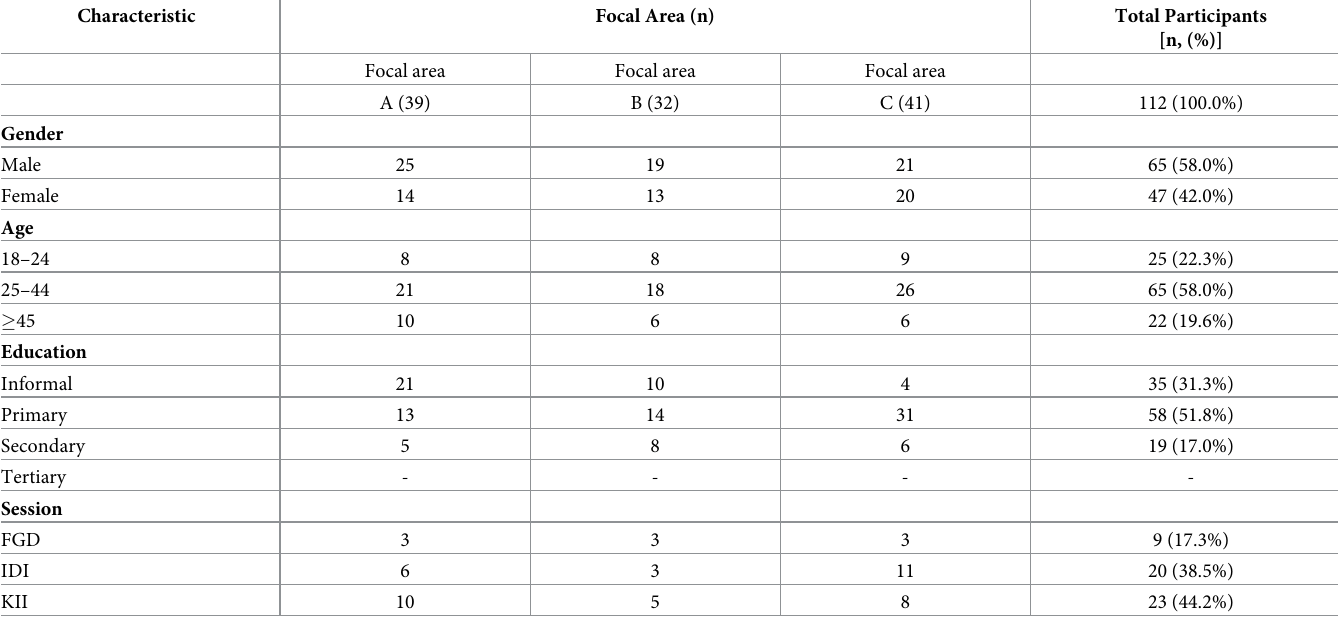
Table 1. Demographics of study